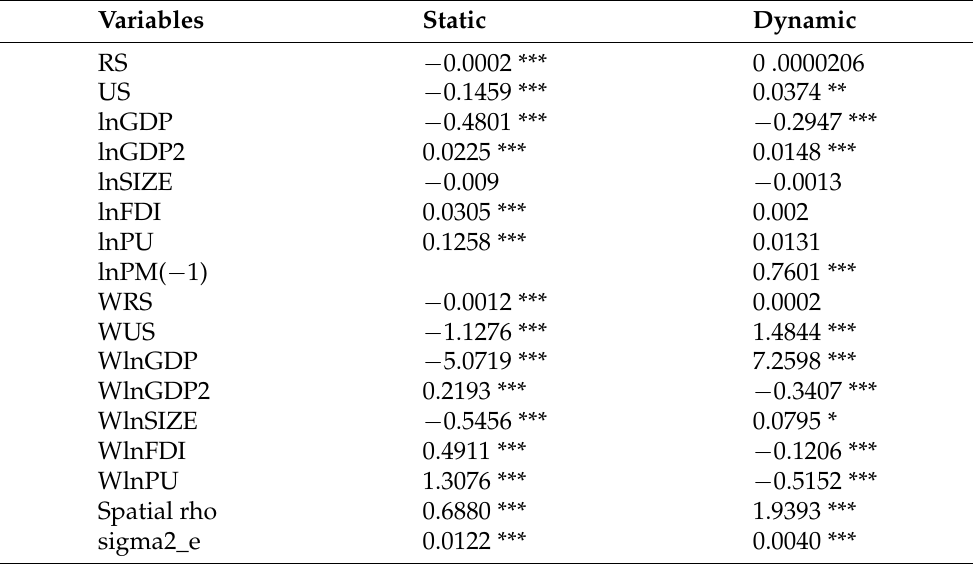
Table 7. SDM parameter estimation.